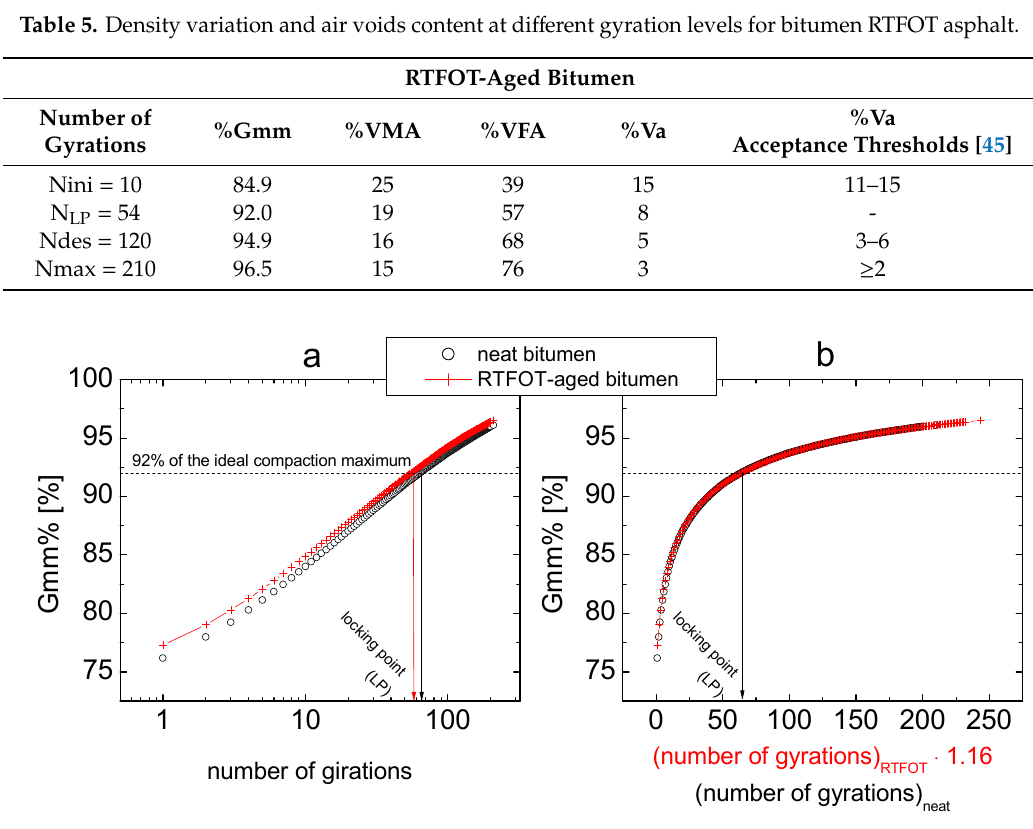
Table 4. Density variation and air voids content at di ff erent gyration levels for neat bitumen asphalt. Neat Bitumen